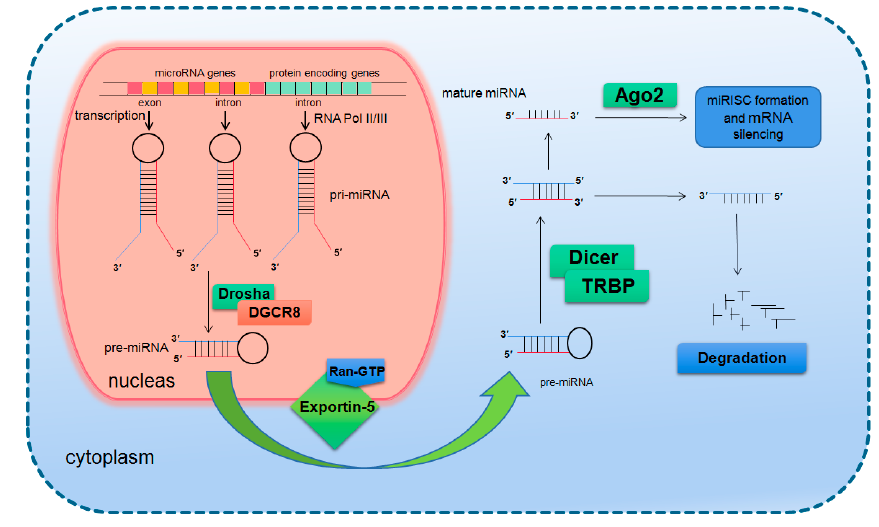
Figure 1. Basic miRNA processing pathway.